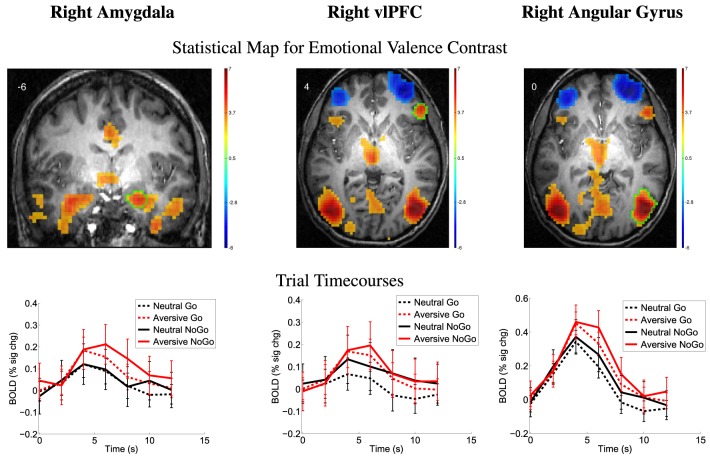
Top row: Statistical t-map for emotional valence contrast (aversive − neutral distractors, collapsed across Go/NoGo). Red and blue regions, respectively, exhibited larger contrast magnitudes for aversive and neutral distractor trials. All results p < 0.05 (corrected for multiple comparisons). Color bar indicates t-value scaling. Slice Y- or Z-coordinate in MNI space shown in upper-left. Images' left side corresponds to left side of brain. vlPFC: ventrolateral prefrontal cortex. Second row: Mean deconvolved timecourses for four trial types for regions outlined in green in first row. Error bars denote mean across all participants' standard error of mean activation time course values.